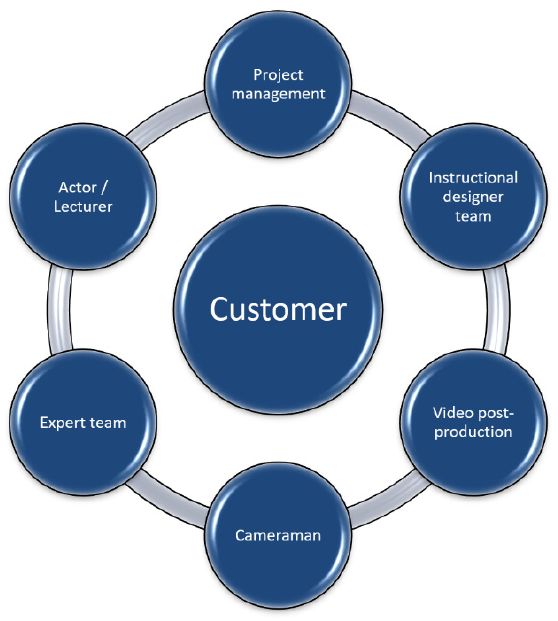
Figure 1. The proposed structure of the team.